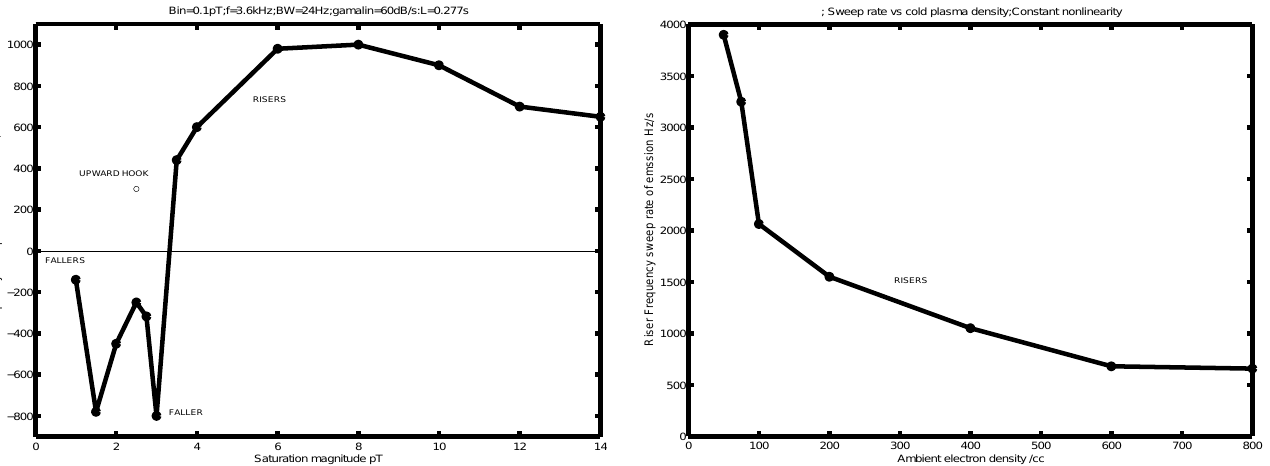
Fig. 10. Dependence of the emission sweep rate on the saturation magnitude employed in the code. Note that at magnitudes > 4pT, well above the trapping threshold, there is little dependence. Low saturation levels are weak triggering situations, and give fallers.